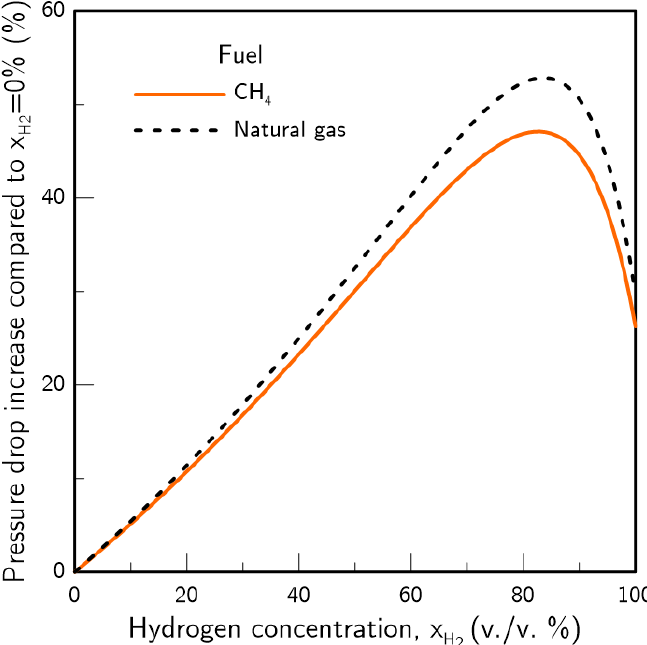
Figure 3. Impact of hydrogen blending on pipeline pressure drop for constant energy demand and unchanged pipe